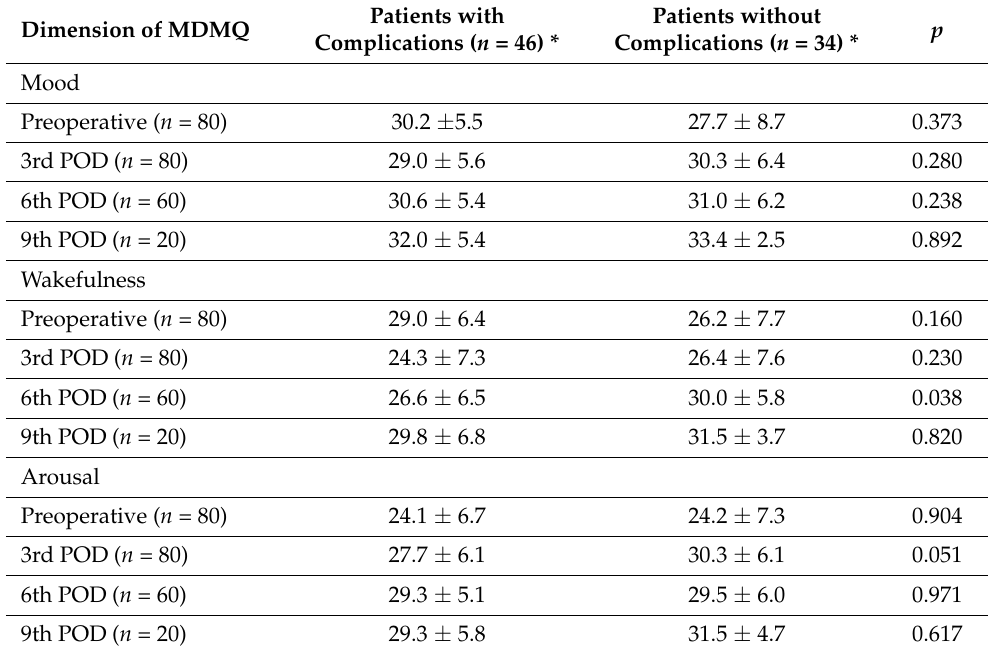
Table 5. Results of MDMQ in patients with development of postoperative complications compared to patients without